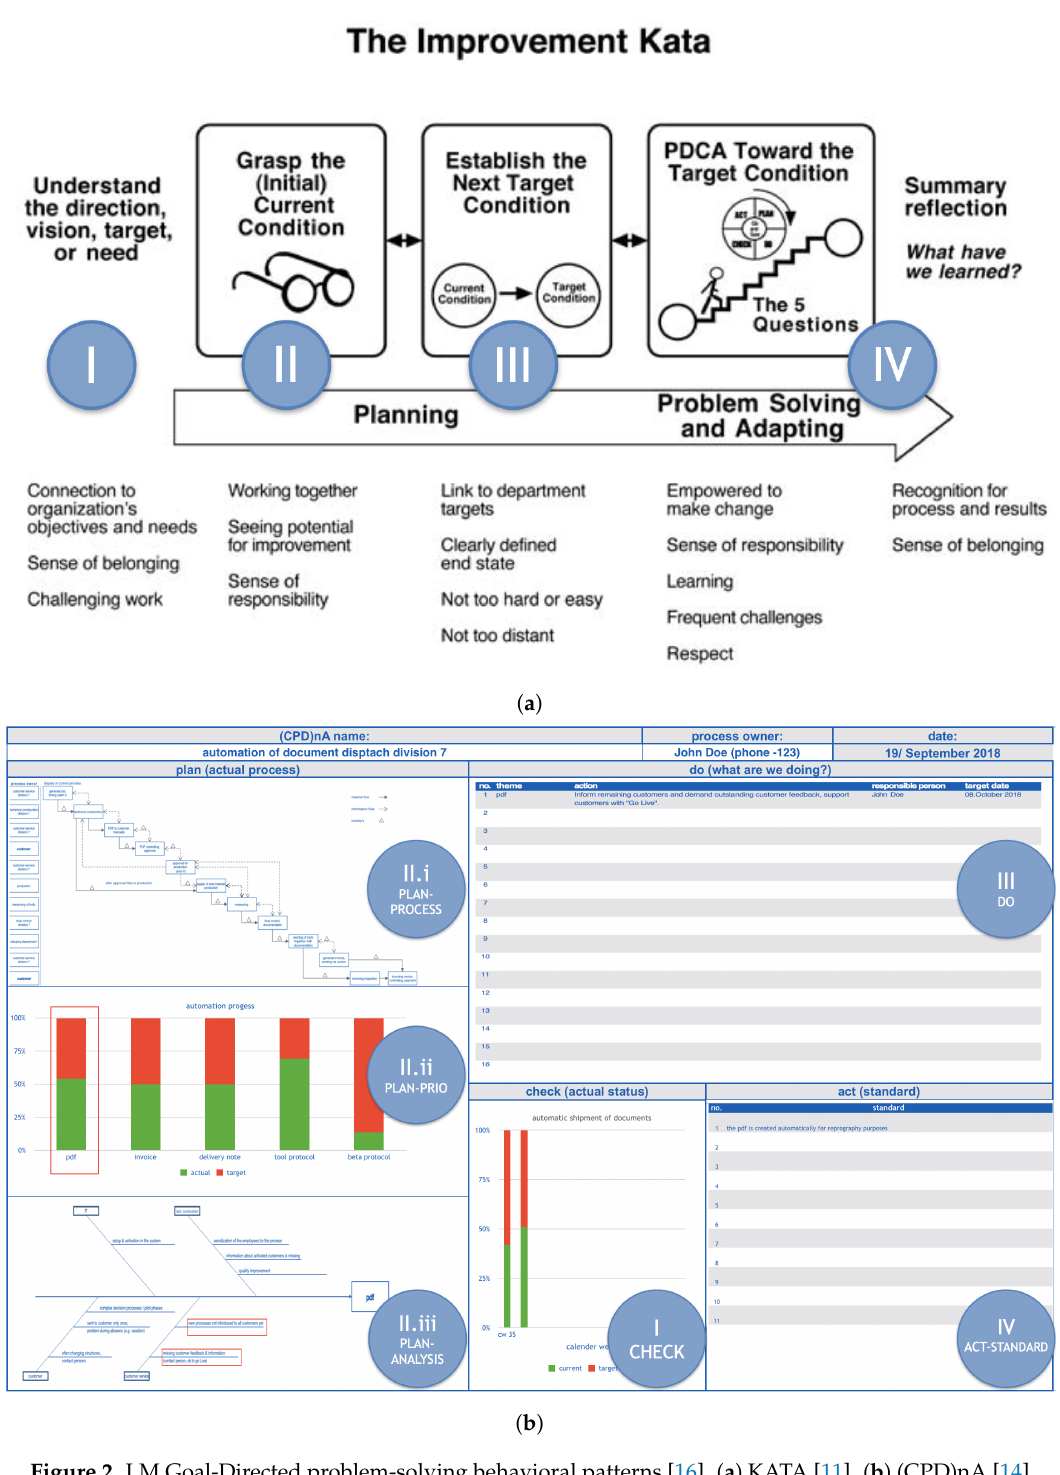
Figure 2. LM Goal-Directed problem-solving behavioral patterns [16]. ( a ) KATA [11]. ( b ) (CPD)nA [14] by Norbert Rosenfeld. Saueressig GmbH. Vreden. Germany. Reproduced with